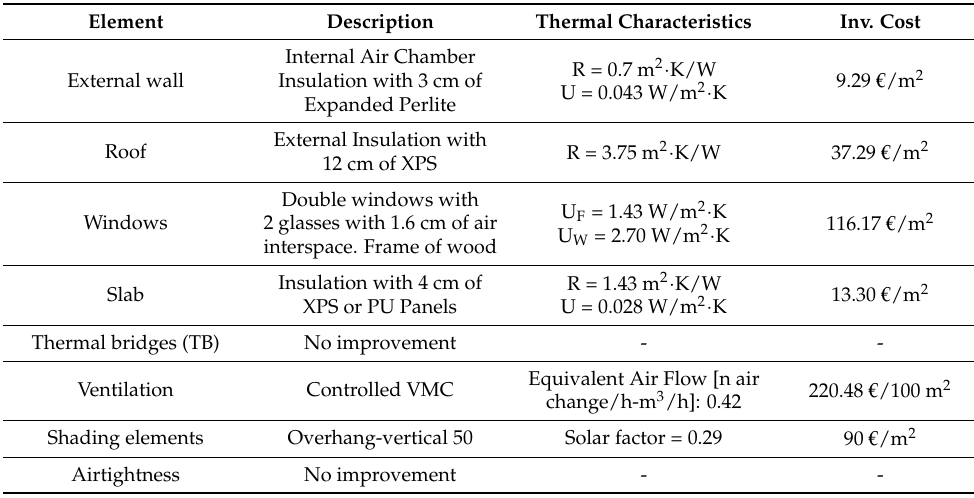
Table A6. POS9: Renovation measures of solution 3.